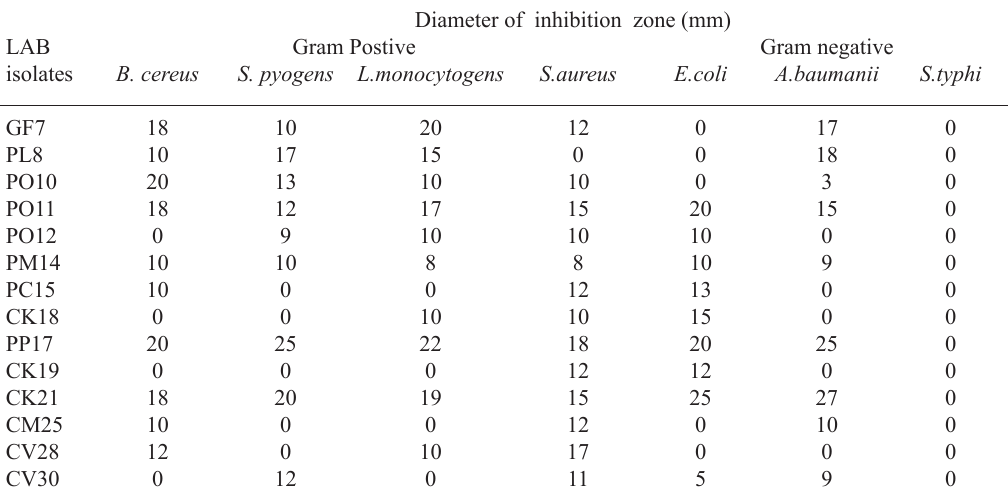
Table 2. Antimicrobial activity of LAB isolates against some pathogenic bacteria Diameter of inhibition zone (mm) LAB Gram Postive Gram negative